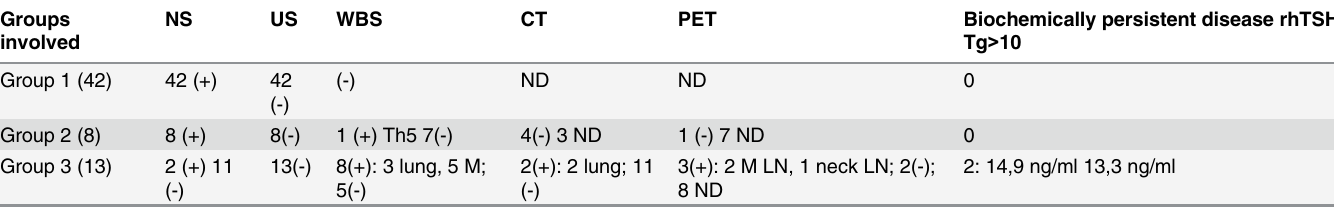
Table 2. Results of imaging studies in involved groups of patients. Groups involved